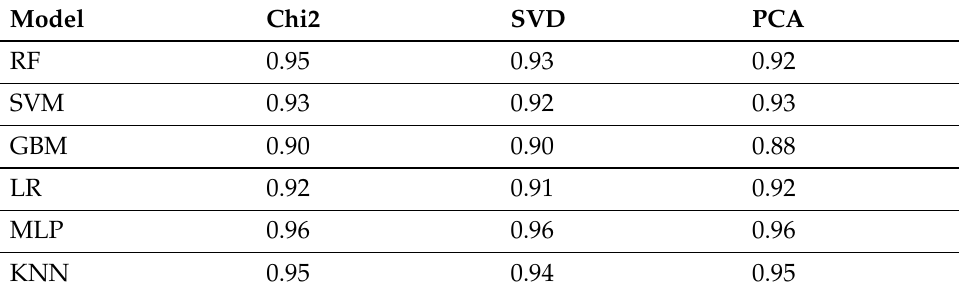
Table 8. Accuracy of classifiers using 20 most important features.